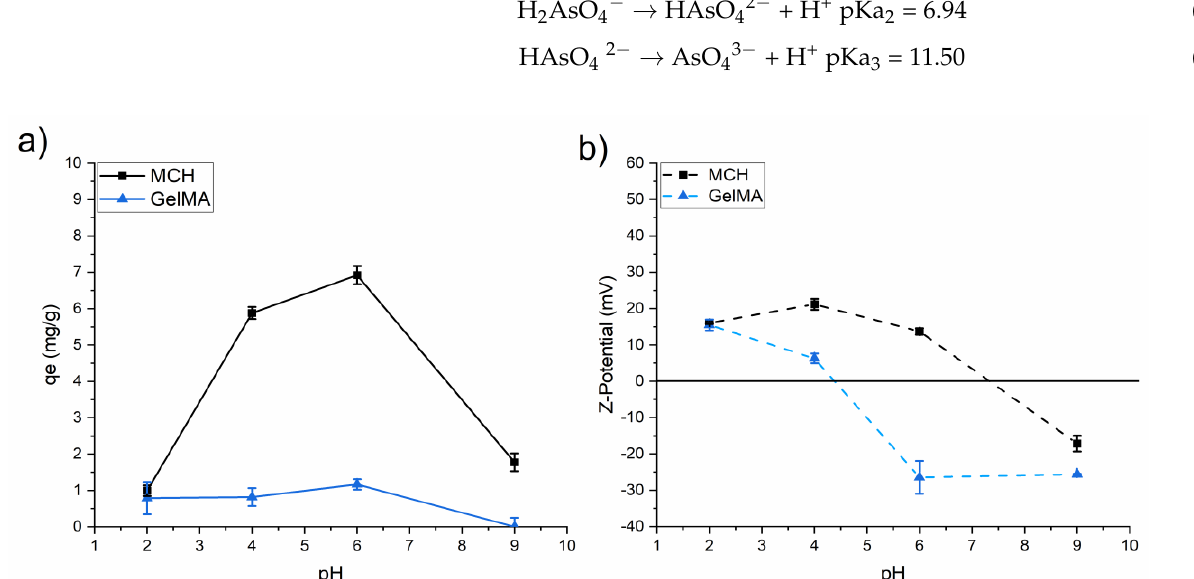
Figure 6. ( a ) q e values of As(V) as a function of pH ( C 0 = 10 mg/L) and ( b ) Z-potential as a function of pH for the different investigated UV-Cured hydrogels.